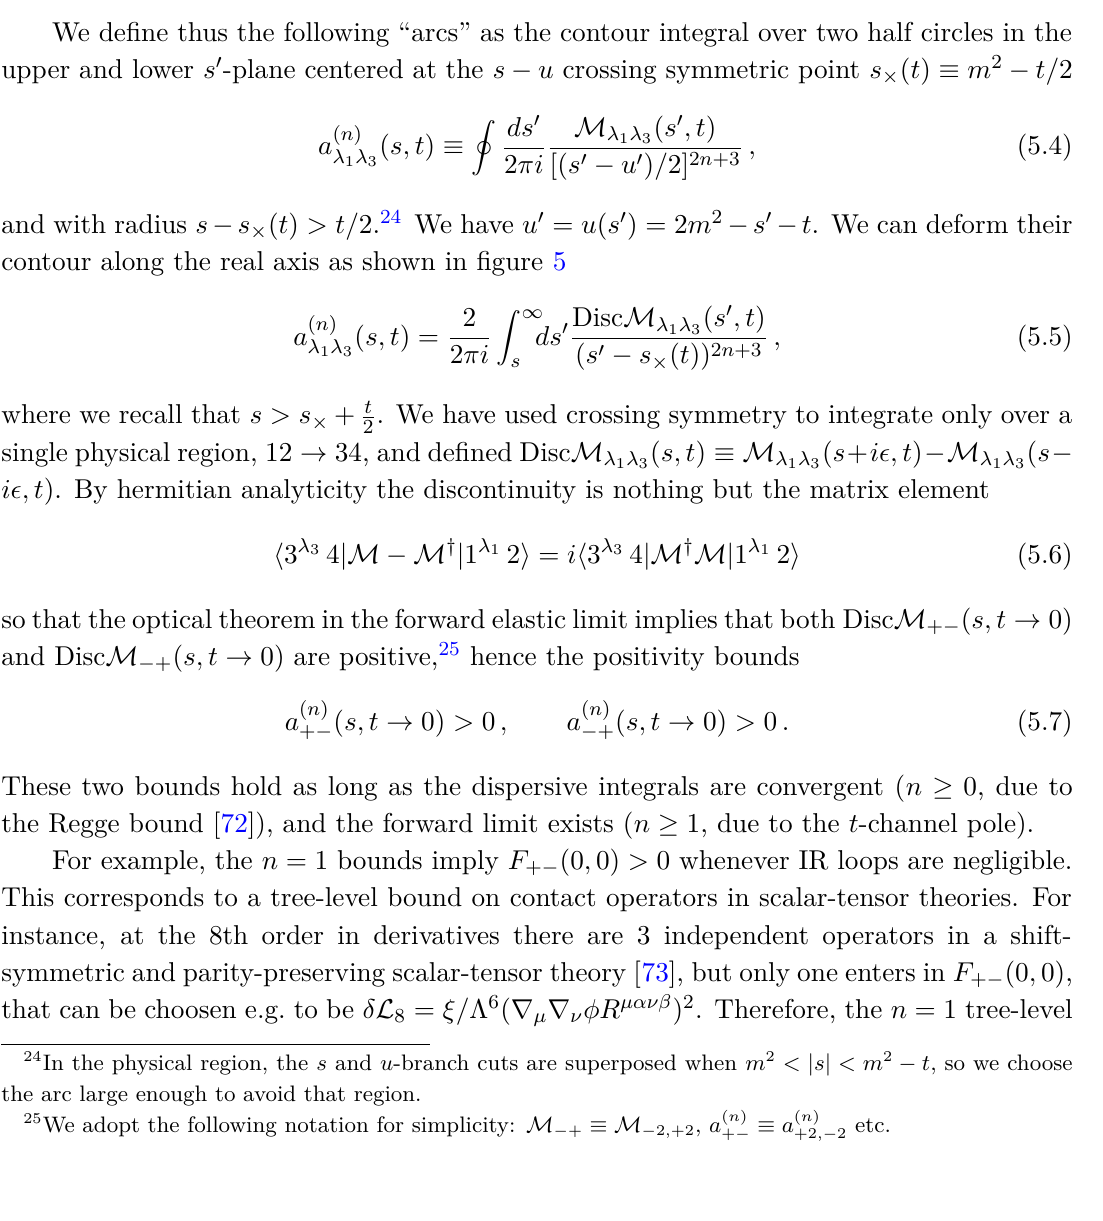
Figure 5 . Thick blue lines represent the contour integral defining the arc (5.4). Lighter blue lines correspond to the contour deformation giving rise to the UV representation (5.5). Orange lines on the real axis represent s and u channel